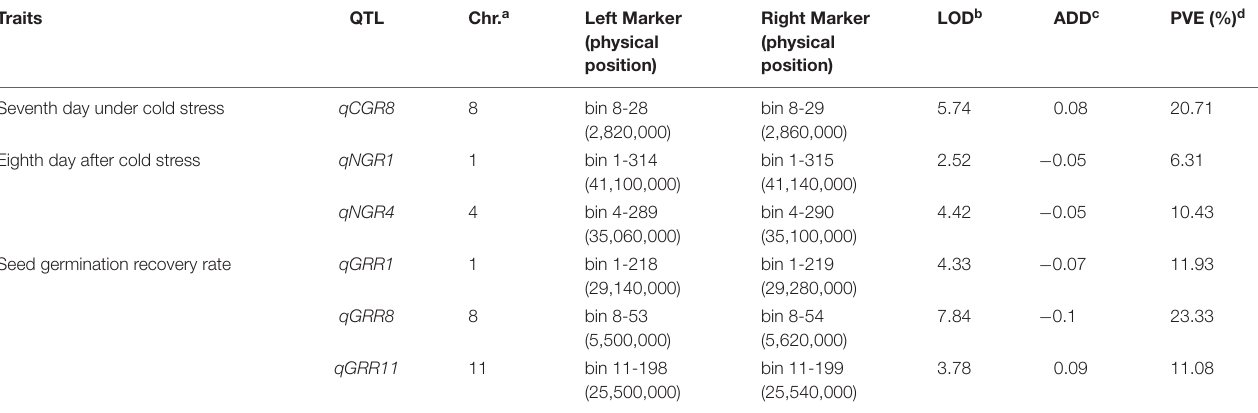
FIGURE 4 | The germination of the two parents: Changhui 891 (left) and 02428 (right) on seventh day (A) and eighth day (B) . TABLE 2 | Putative QTL associated with seed germination under cold stress in the BRIL population in